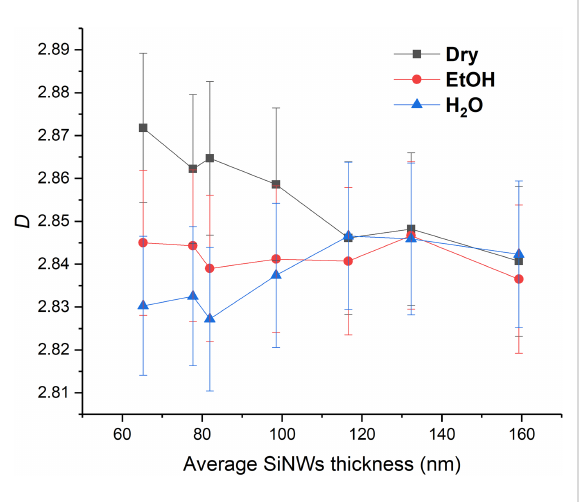
Figure 8: Fractal dimension ( D ) of Ag-plated SiNWs after immersion in EtOH and H 2 O.